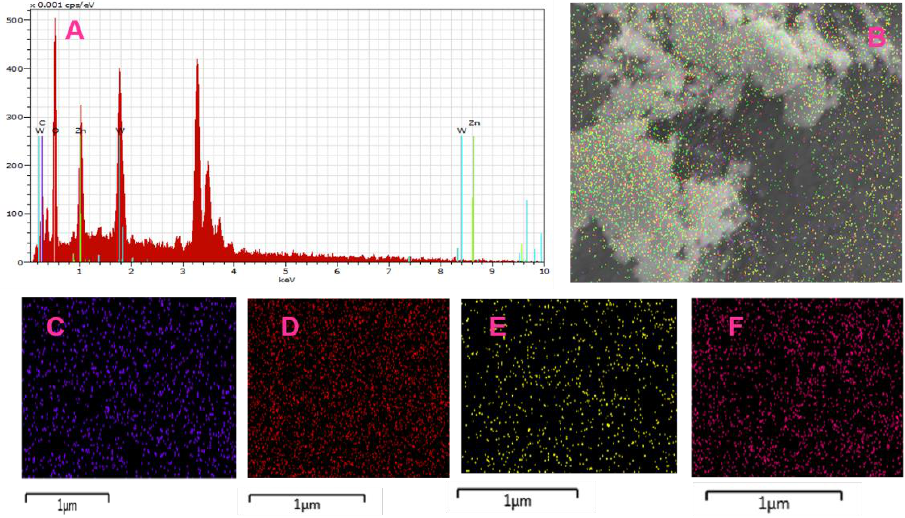
Figure 2. ( A ) EDAX; ( B ) elemental mapping of ZnWO 4 /CB composite; ( C ) Zn; ( D ) W; ( E ) O; and ( F ) C.